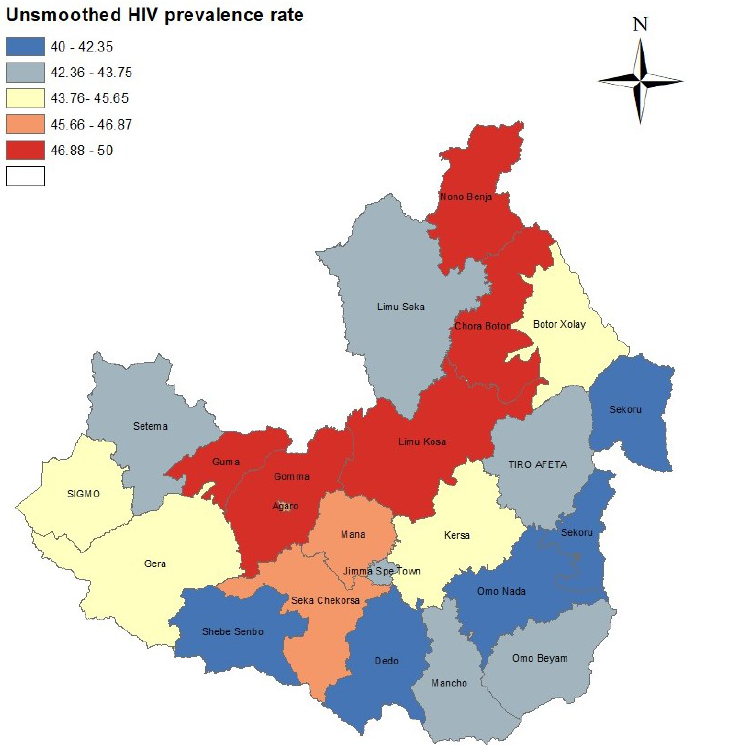
Figure 1. Geographical distribution of raw (unsmoothed) HIV prevalence in Jimma Zone at district level.